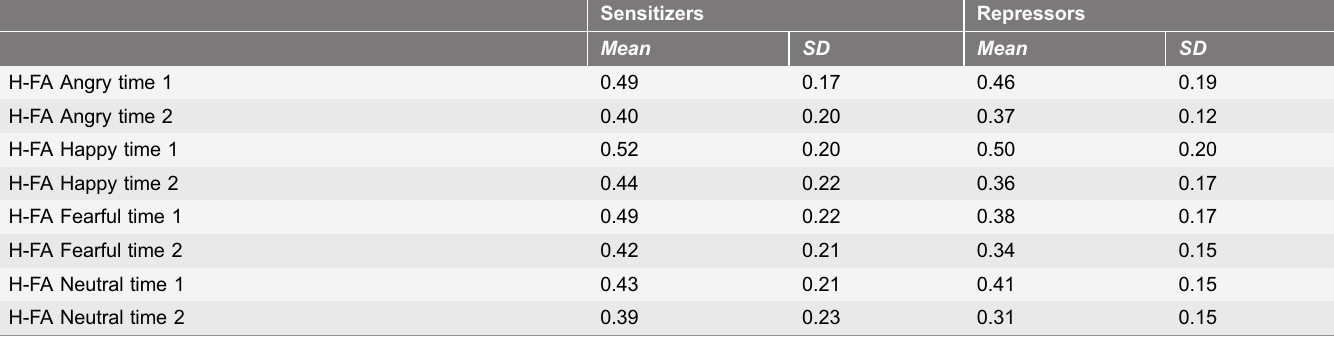
Sensitizers Repressors Mean SD Mean